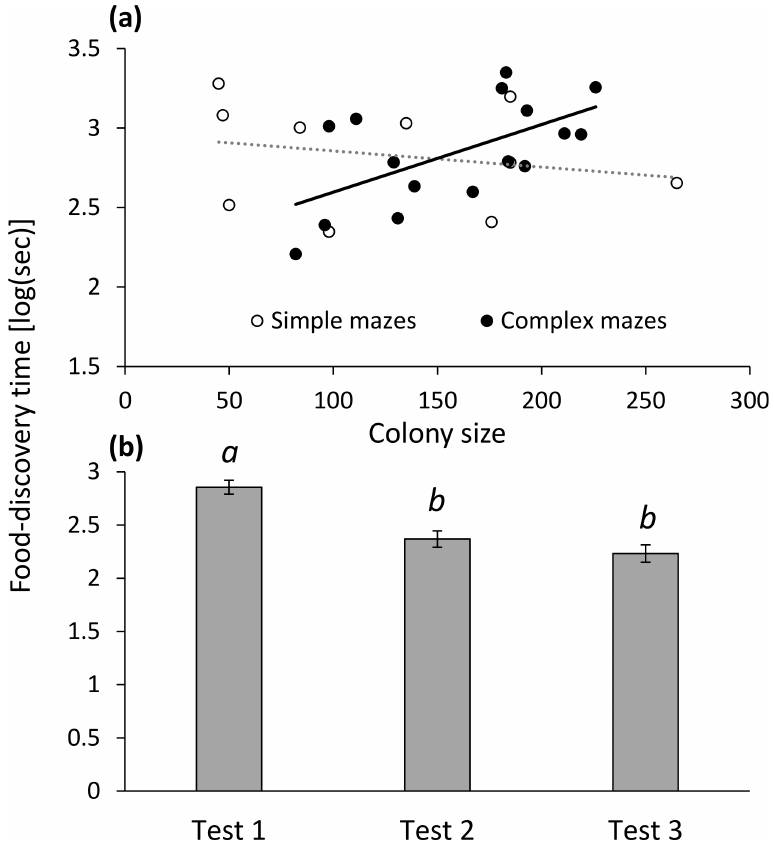
Fig 2. (a) The interaction between colony size and maze complexityin their effect on food-discovery time on the first test; (b) the decreasein food-discovery time with successivetests performed on the same day. Letters denote significantdifferences accordingto a post-hoc